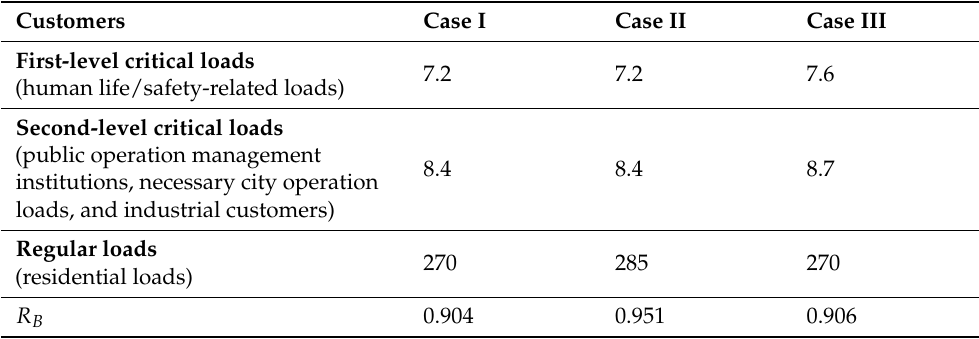
Table 2. Value of the resilience metric for different cases using (2).